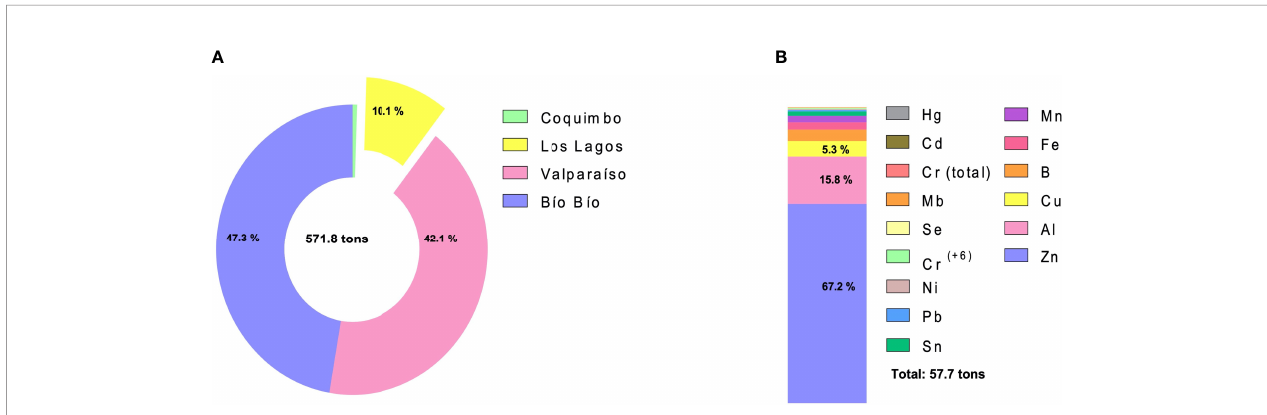
FIGURE 3 | Heavy metals discharged in Chilean coasts during 2019. (A) Percentage of heavy metals spill (expressed in tons) in major regions of mussel ’ s cultivation during 2019. (B) Percentage of each heavy metal spilled (in tons) in Los Lagos Region during